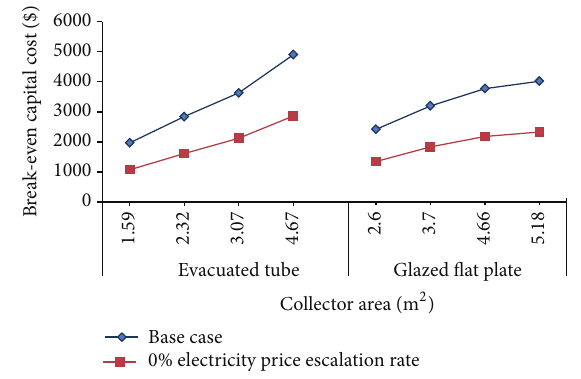
Figure 7: Break-even capital cost sensitivity for electricity